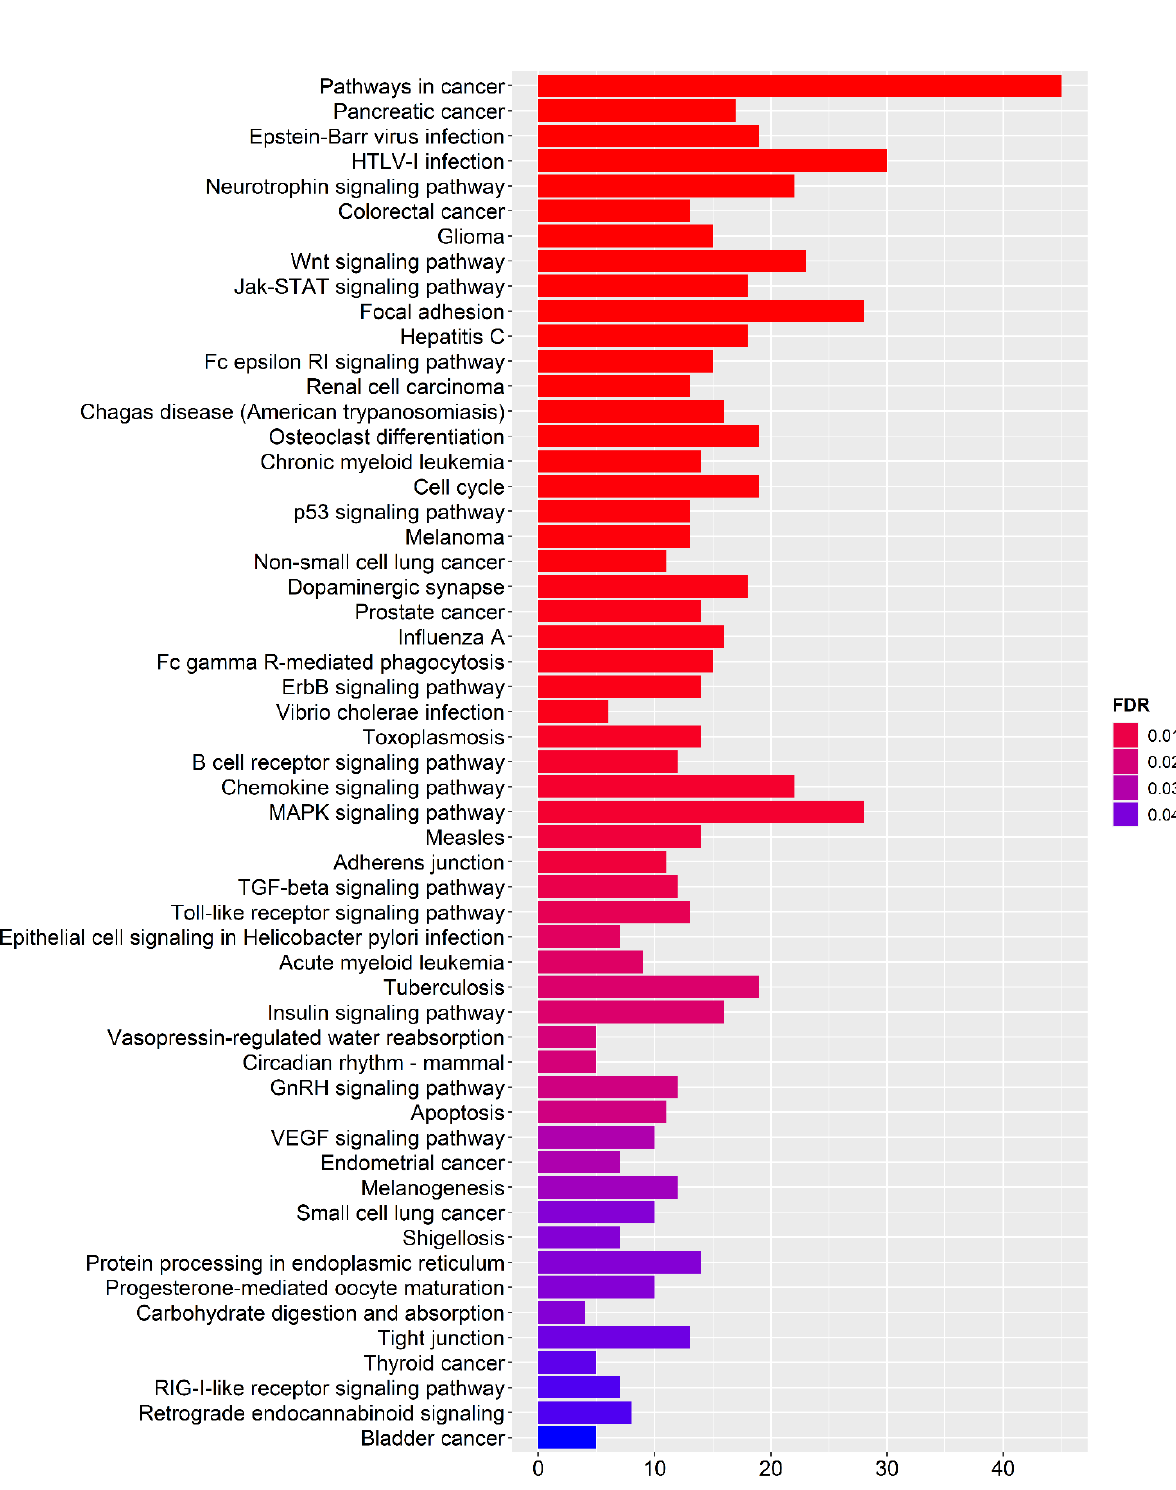
Figure 6. Pathway Enrichment Analysis . The y -axis represents the enriched KEGG items; the x -axis shows the gene count. The color of each bar represents enrichment significance. Only pathways with FDR ≤ are considered as statistically significant.